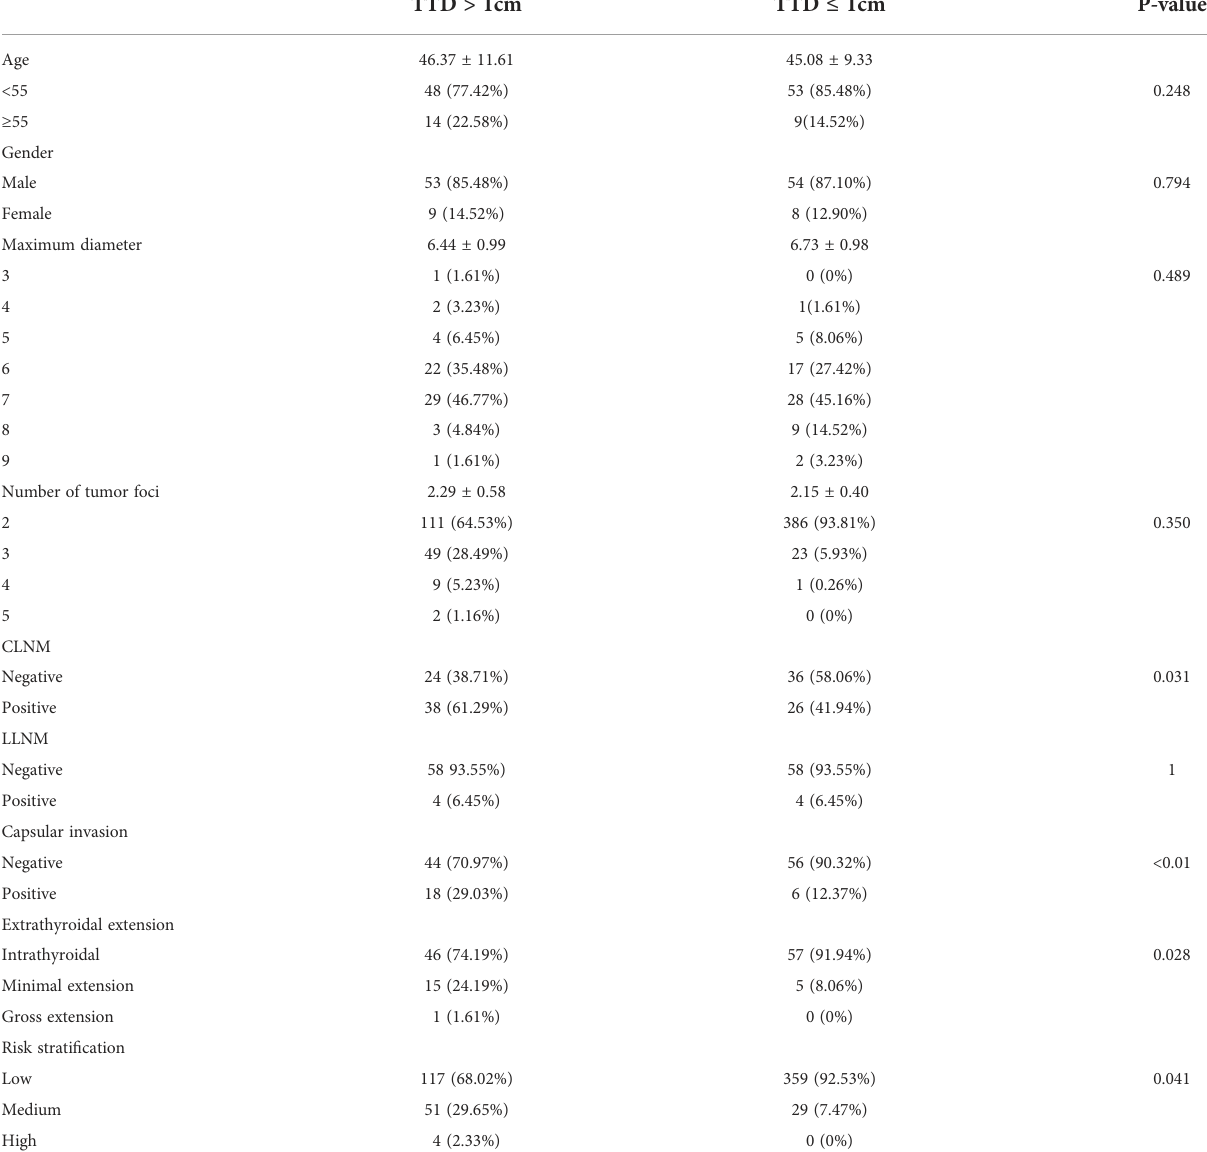
TABLE 3 Comparison of clinicopathological features between multifocal PTMC with TTD >1 cm and TTD <1 cm after